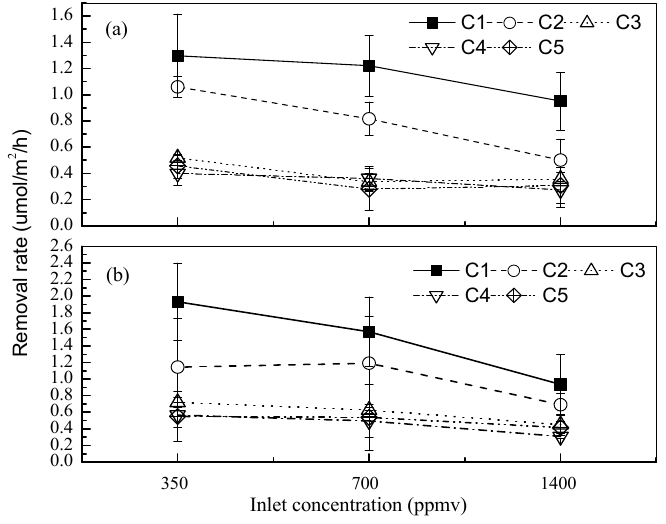
Figure 8. The removel capacity on formaldehyde, actealdehyde, propionaldehyde, n-butyraldehyde, valeraldehyde by ( a ) Schefflera octophylla (Lour.) Harms ; and ( b ) Chamaedorea elegans (Lour.) Harms at three CO 2 concentrations (350, 700, 1400 ppmv). C 1 : formaldehyde; C 2 : acetaldehyde; C 3 : propionaldehyde; C 4 : N-butyraldehyde; C 5 : valeraldehyde Means ( n = 3) ± S.E. are shown. Significant differences for p < 0.05 are shown with least significant (LSD) test.